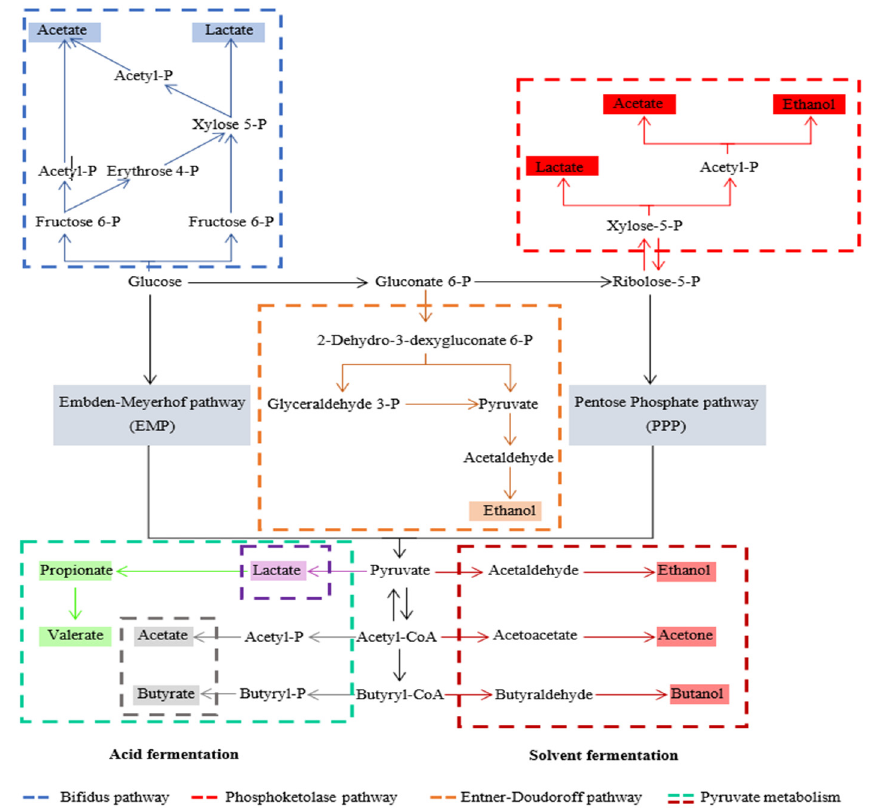
Figure 1. Metabolic pathway of acidogenic fermentation, modified from [64].